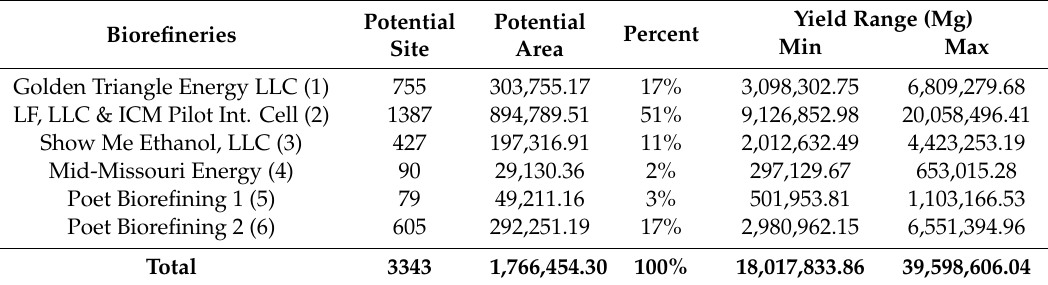
Table 7. Potential feedstock by biorefinery in scenario 2.